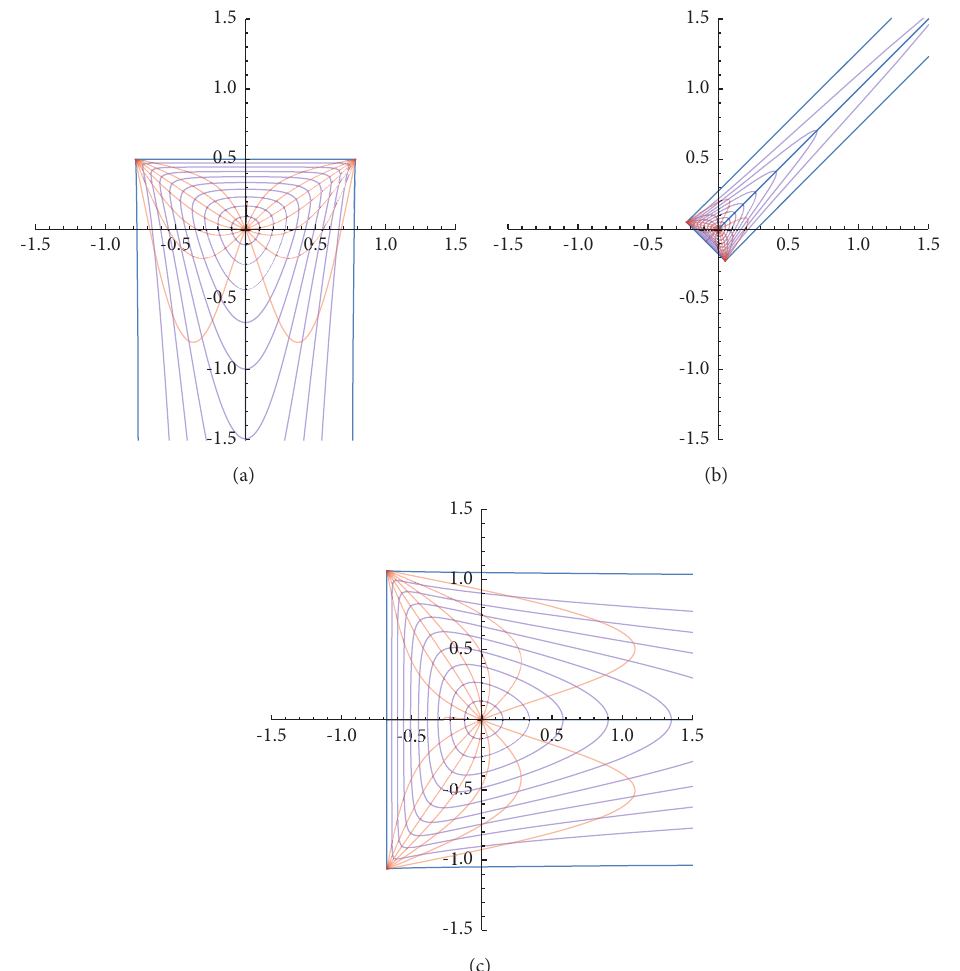
Figure 2: Images of D under f